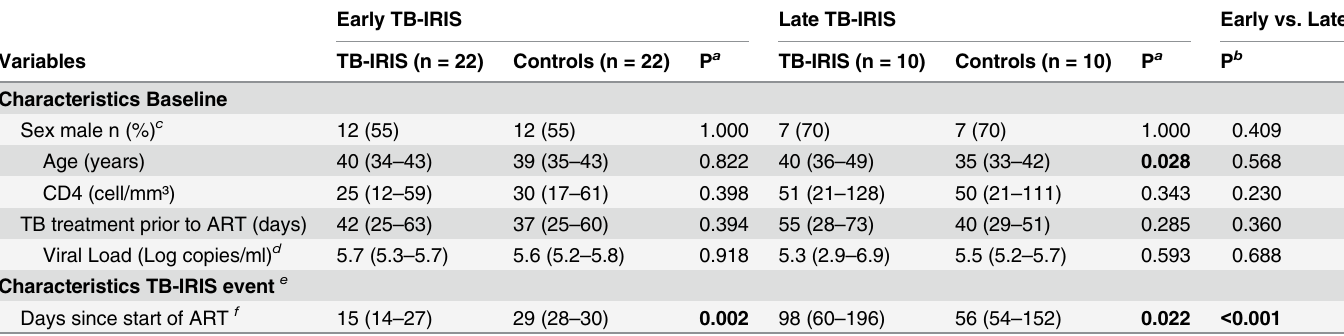
Table 1. Characteristics of TB-IRIS patients and matched controls for flow